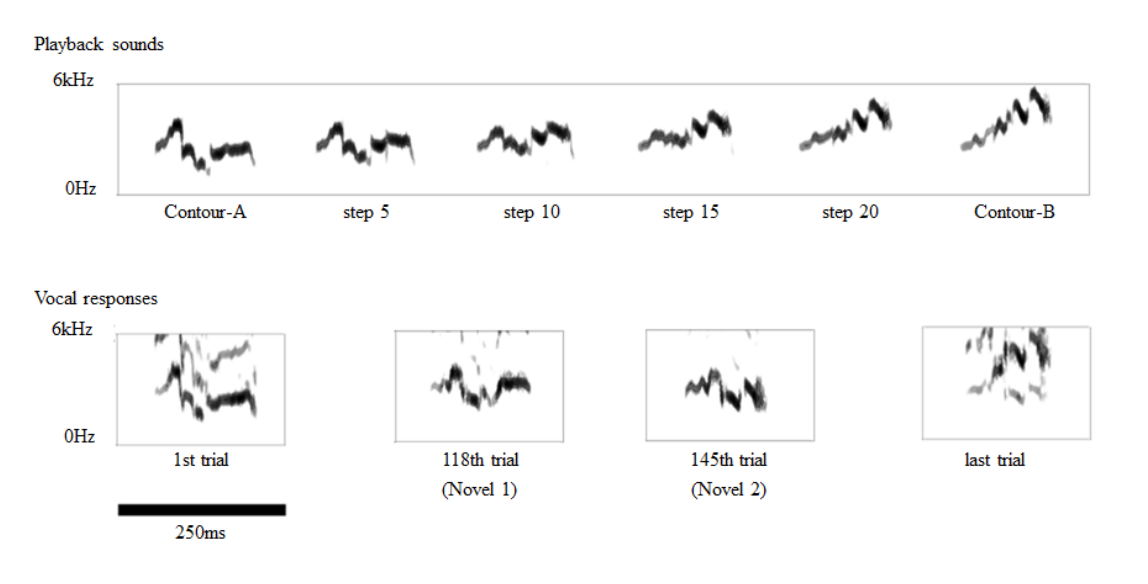
Figure 3 . Example of the sound spectrograms of playback sounds and vocal responses in a session of Experiment 3 (corresponding to Figures 2). Novel pattern 1 is quite similar to an intermediate sound (the 5 th step) on the spectrogram. Novel pattern 2 looks like a combination of several parts of the contour-A and B.